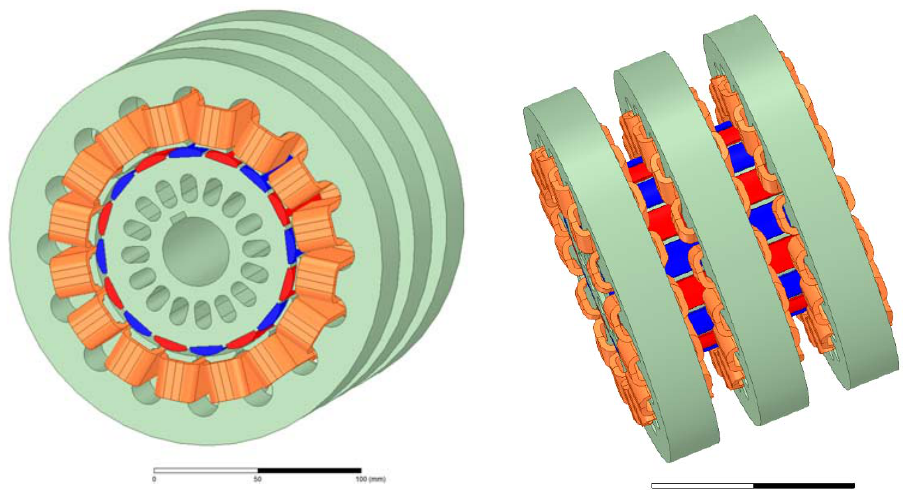
Figure 11. Demonstrative drawing of the proposed three ‐ phase construction.